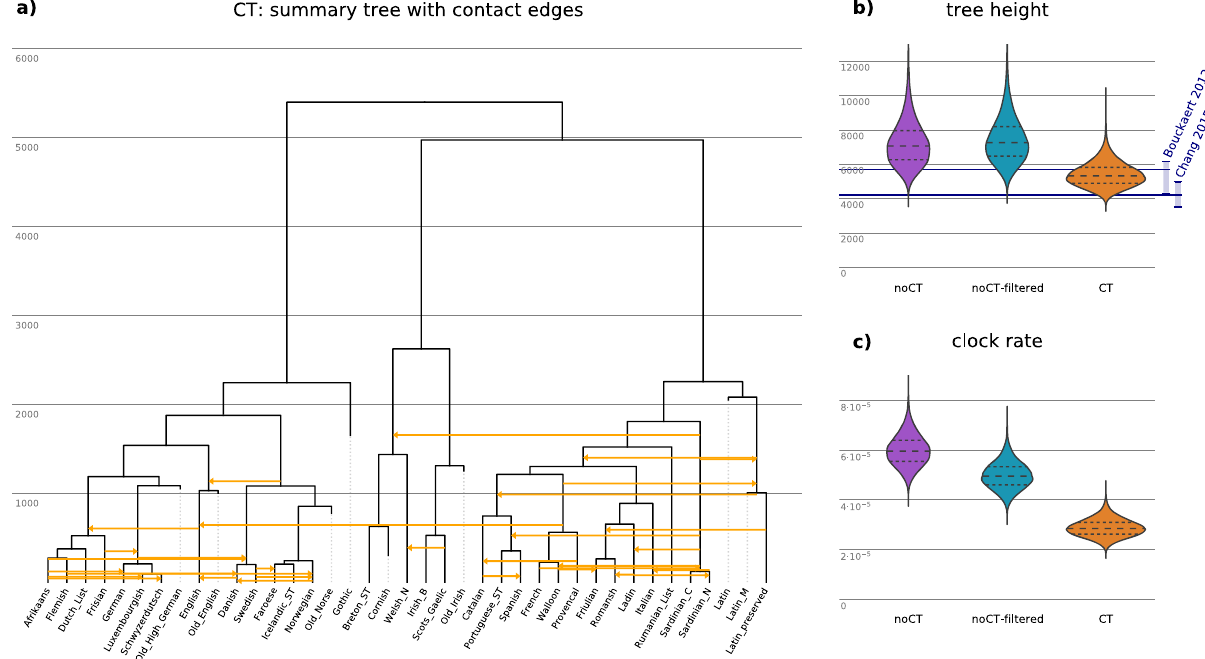
Fig. 5 Reconstructed tree, contact edges and parameters from the case study on the Celtic-Germanic-Romance (CGR) languages. a The reconstructed language tree and contact edges for the CGR languages. b The posterior distributions of the root height for the noCT, noCT- fi ltered, and CT models (mean height of 7206.2, 7449.8, and 5384.0 years, correspondingly). For comparison, we added the reconstructed root age of CGR as estimated by Bouckaert et al. (2012) and Chang et al. (2015) (mean and 95% credible intervals). c The posterior distribution of the clock rates (see Supplementary Material, Section S5.2) with a mean of 5.97 × 10 − 5 (noCT), 4.96 × 10 − 5 (noCT- fi ltered), and 2.84 × 10 − 5 (CT) substitutions per